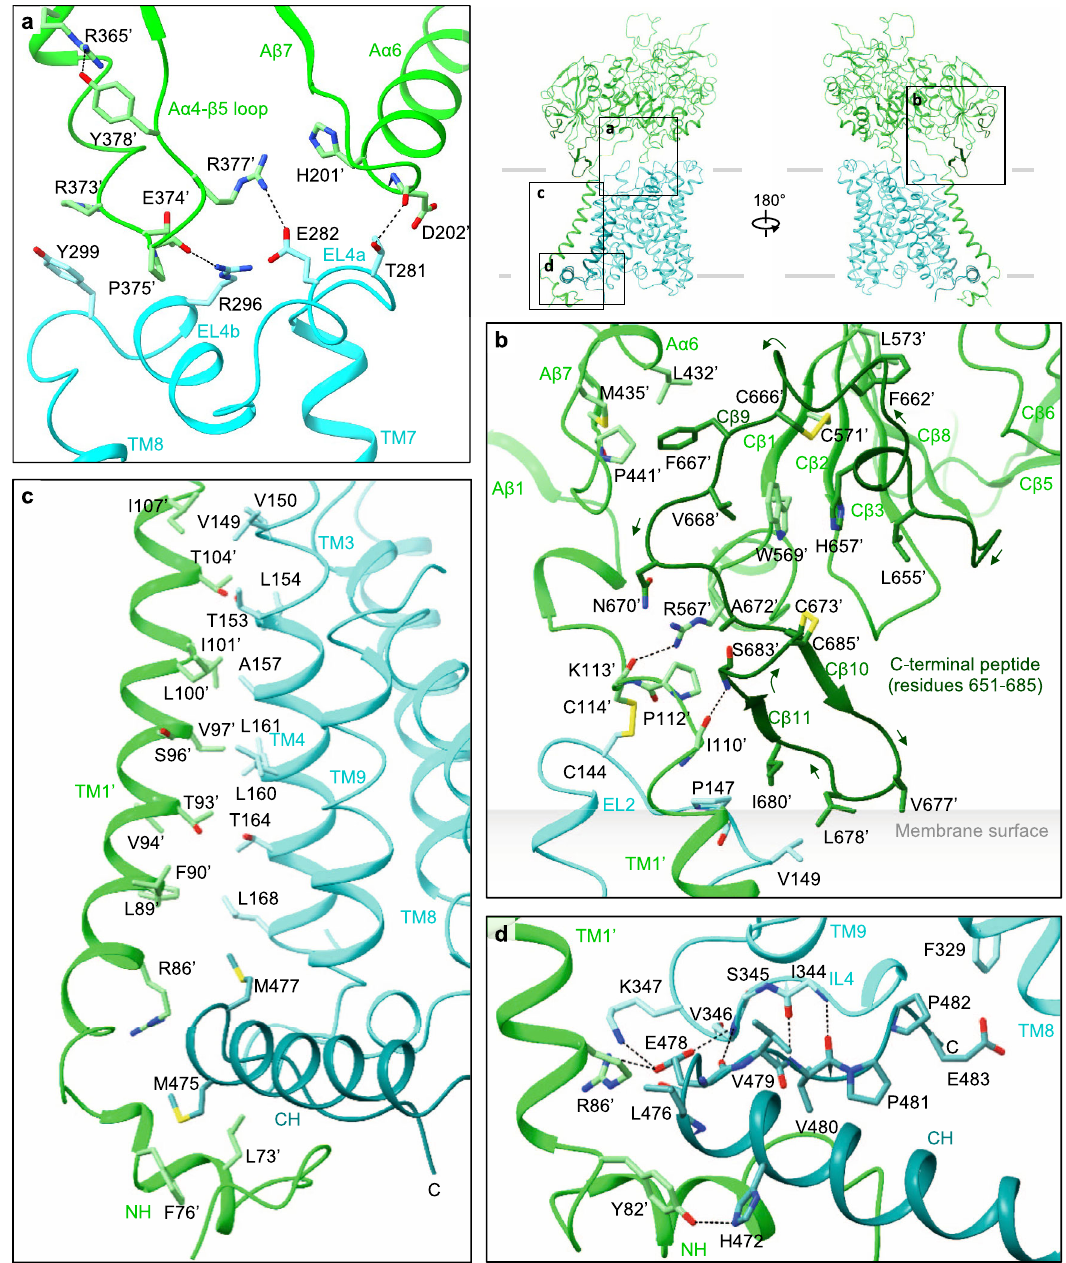
Fig. 3 The interface analysis of b 0, + AT – rBAT. a Extracellular interactions formed by the A α 4- β 5 loop, A α 6, EL4a and EL4b. Key interacting residues are shown, with hydrophilic interactions depicted by dotted lines. Arg365 ′ stabilizes the A α 4- β 5 loop through interaction with Tyr378 ′ . The locations of panels ( a – d ) are indicated on the right. b C-terminal peptide of rBAT. The peptide is dark green for better visibility. Leu678 ′ contacts the membrane surface, as calculated by the PPM server (https://opm.phar.umich.edu/ppm_server). c Intramembrane interactions. TM1 ′ and TM4 have numerous hydrophobic residues that pack against each other. The C-terminal helix (CH) of b 0, + AT is dark cyan for better visibility. d CH and ‘ Val-Pro-Pro ’ motif of b 0, + AT, forming intracellular is surrounded by the acidic side chains of Asn214 ′ , Asp284 ′ and Glu321 ′ and the main chain carbonyl groups of Tyr318 ′ and Leu319 ′ , indicative of a metal cation (Fig. 5b). Based on the coordination geometry and the sequence homology with known Ca 2 + -binding sites of amylases 25 , we assigned this density to a bound Ca 2 + ion. As we did not supply any Ca 2 + during pur- i fi cation, the bound ion has most likely been acquired during protein expression. This density was also observed in the recent structures of human rBAT and assigned as Ca 2 + , supporting a conserved binding site 15,16 .